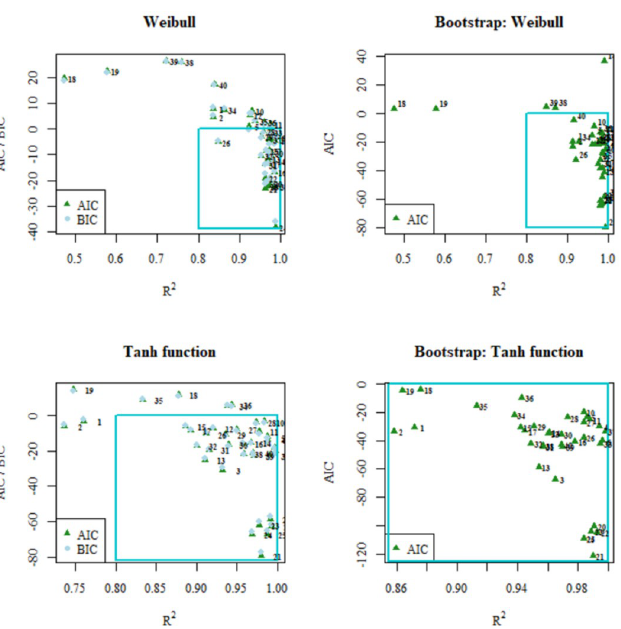
Fig 7. AIC / BIC vs R 2 plots obtained from linear regression fitting (left) and AIC vs R2 obtained from Bootstrap fitting (right) for the mathematical models of Weibull (top) and Hyperbolic Tangent Function (bottom).